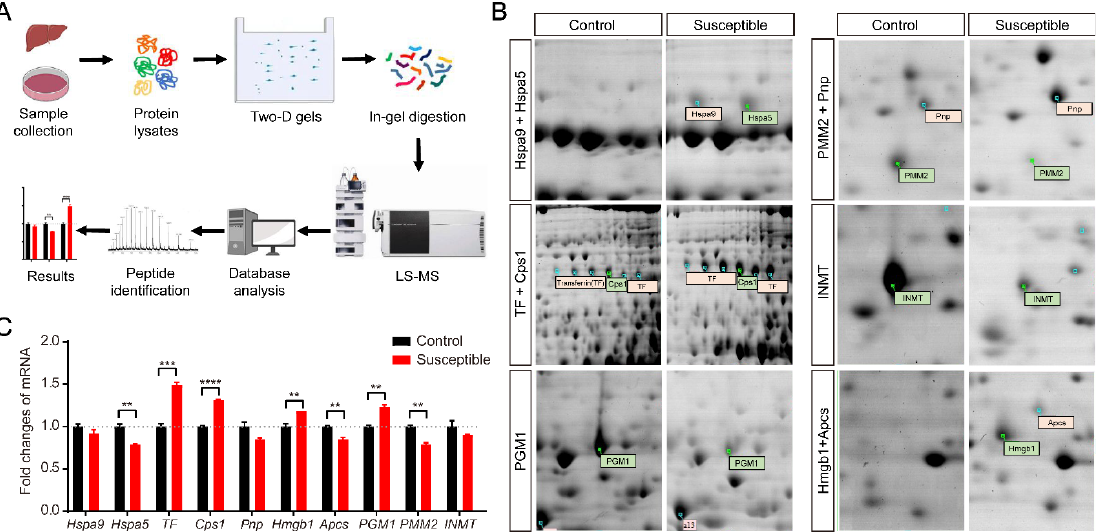
Figure 2. Identification of differential expression of protein in the livers in CSDS induced susceptible mice. ( A ) Schematic diagram of two-dimensional electrophoresis and mass spectrometry. ( B ) Representative 2-DE gel pattern of differentially expressed protein between non-stressed control and susceptible mice indicated by identical names, respectively. ( C ) qRT-PCR analysis of differentially expressed proteins at transcriptional level in liver RNA extractions from non-stressed controls ( n = 3) and susceptible mice ( n = 3). Hspa9 : heat shock protein 9, Hspa5 : heat shock protein 5, TF : transferrin, Cps1 : carbamoyl phosphate synthase 1, Pnp : purine nucleoside phosphorylase, Hmgb1 : High mobility group protein 1, Apcs : serum amyloid P component, PGM1 : phosphoglucosidase-1, PMM2 : phosphomannomutase 2, INMT : indoleethylamine N-methyltransferase. Unpaired t test. All data